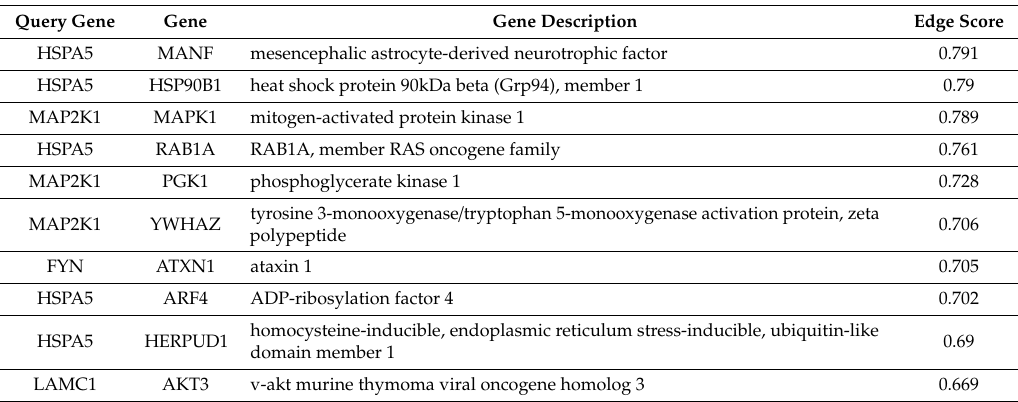
Table 4. Top 10 ranking ASD genes interacting with brain DEGs belonging to the “prion diseases” pathway.